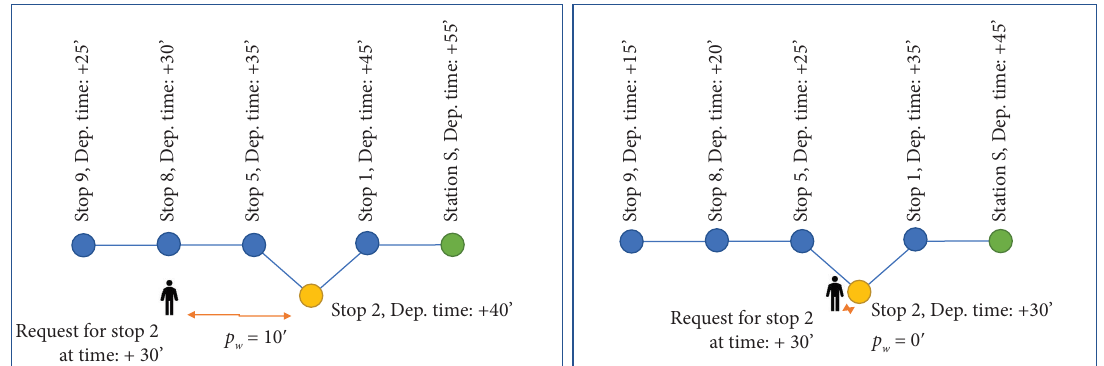
Figure 6: Illustration of improvement operation for a request and the improved line, advancing the departure time of the bus 10minutes to reduce the waiting time of this passenger.